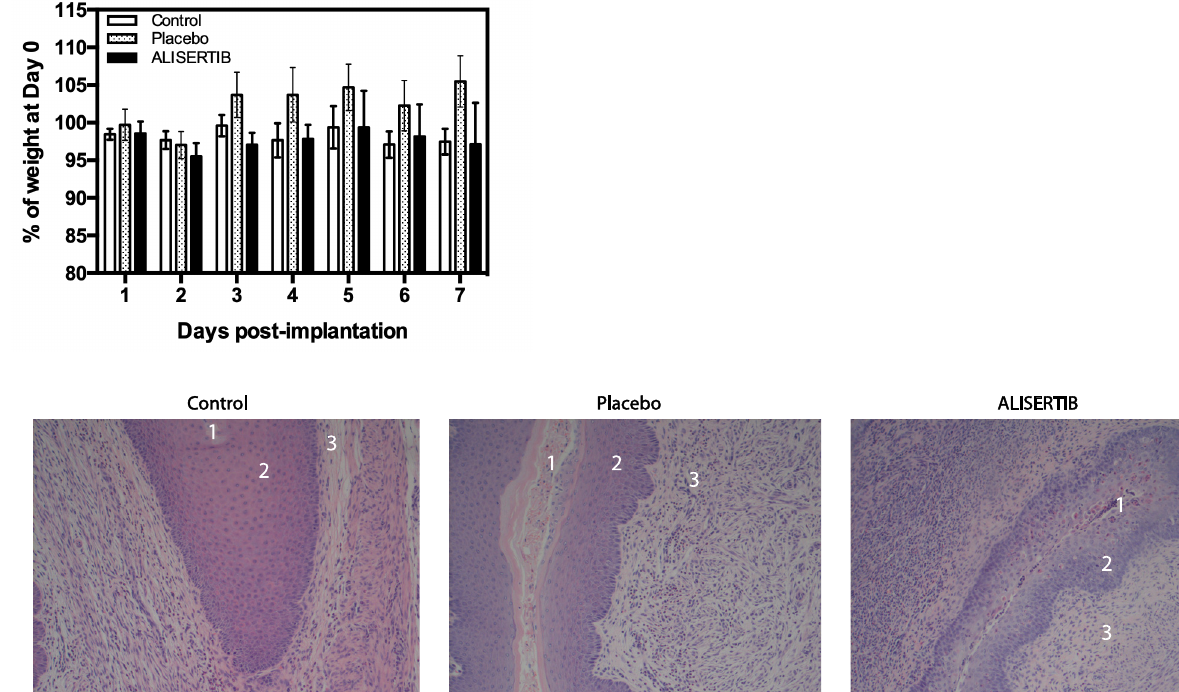
Fig 4. Alisertib-loaded intravaginal rings did not induce overt inflammation in the mouse vaginal tract. FVB mice were either not implanted (control) or implanted with rings containing 1% (w/w) Alisertib in the vaginal tract. Intravaginal rings without Alisertib were used as the placebo. Mice were weighed daily over a week. Data is representative of the percentage of the mean weight at Day 0 ± standard error of mean (SEM) from five mice. Tissue sections of the mice genital tract were examined to any noticeable signs of abscess or inflammation in the (1) vaginal lumen, (2) epithelium and (3) lamina propria regions of the tissue. Tissues were collected at Day 7 and stained with H&E.